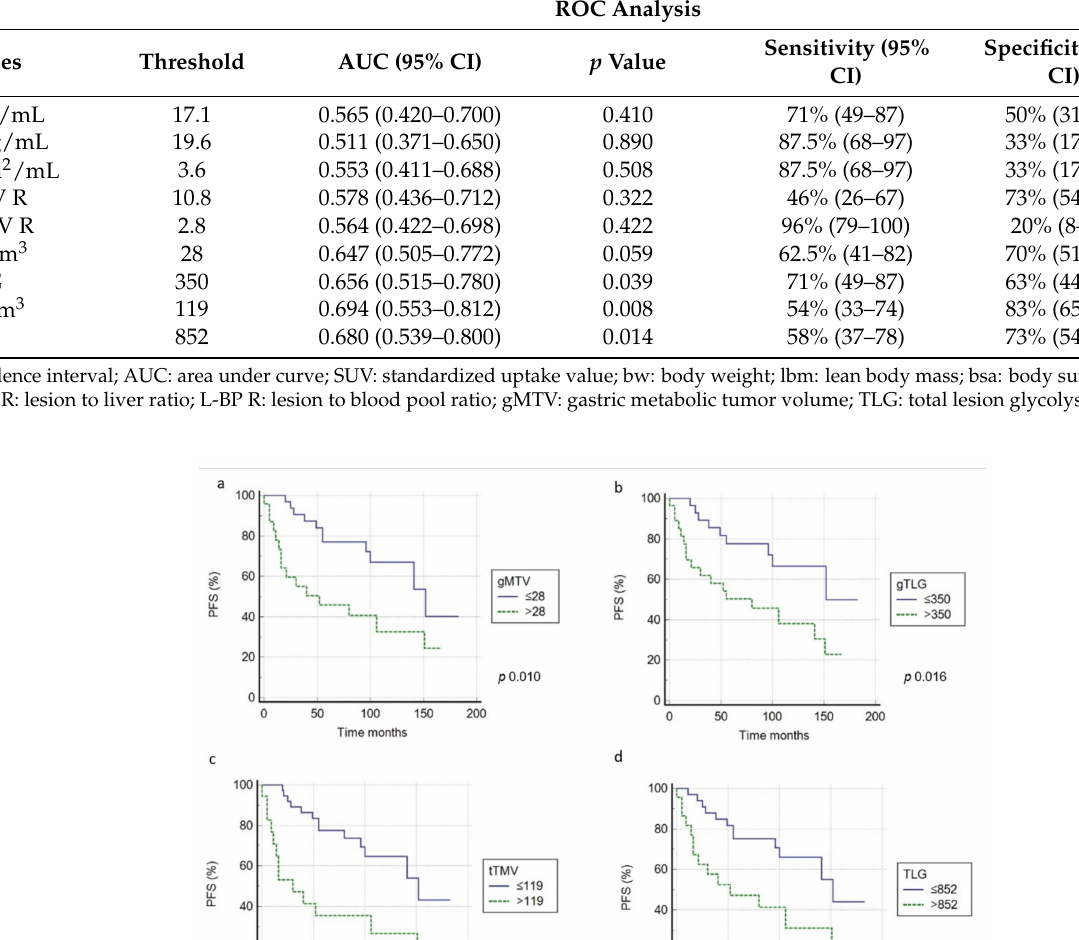
Table 3. Semiquantitative PET/CT variables thresholds derived from ROC analysis. ROC Analysis